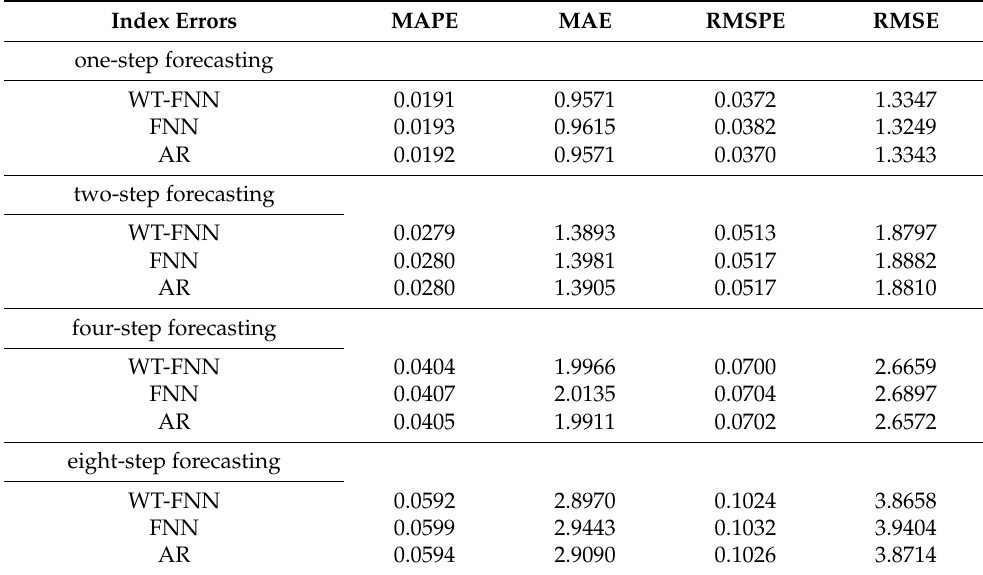
Table 7. Comparisons of predictions from different forecasting models to the alternative benchmark